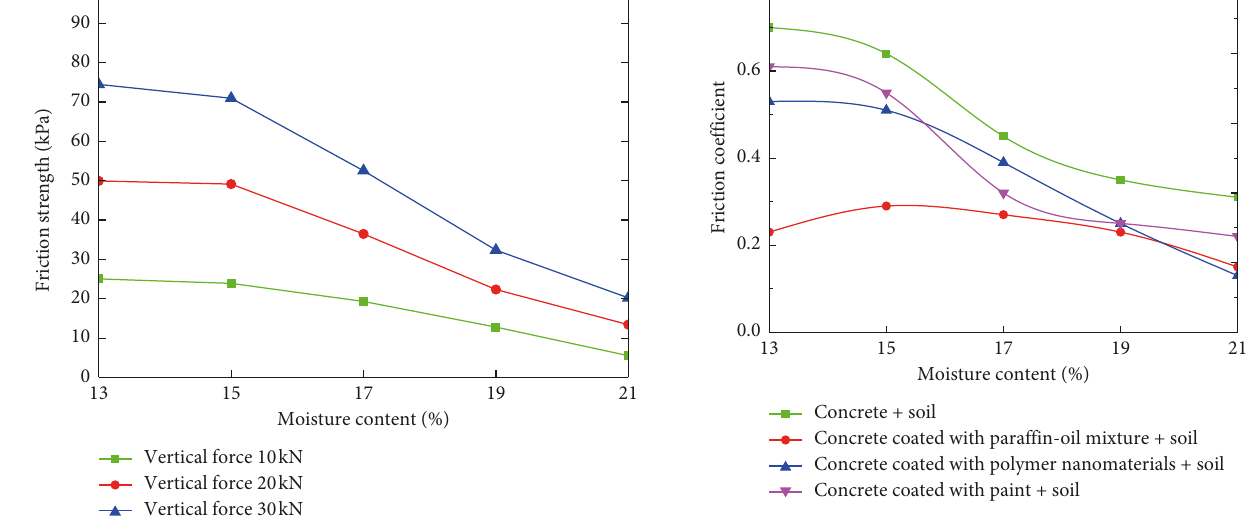
Figure 7: Friction strength of the polymer nanomaterial on the concrete surface and soil for different moisture contents.